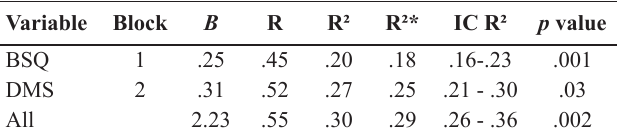
Table 2. Multiple Linear Regression that used the BSQ and DMS on Diet Subscale Variance of the EAT-26 in Male Surfers.